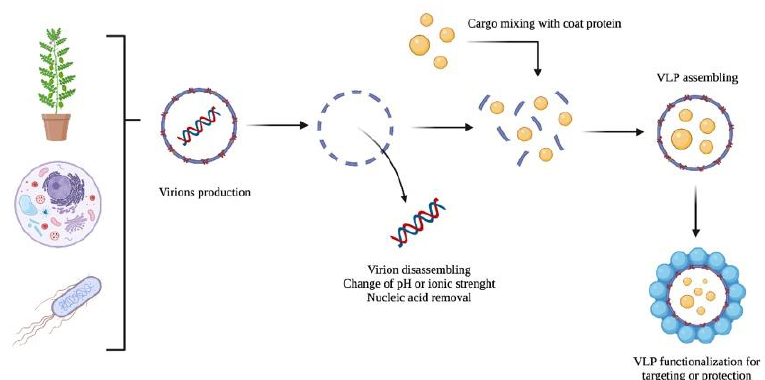
Figure 2. A schematic representation of the VLP production of virions as nanocarriers: (i) production, (ii) disassembling and nucleic acid removal, (iii) cargo encapsulation, and (iv) VLP functional- ization.